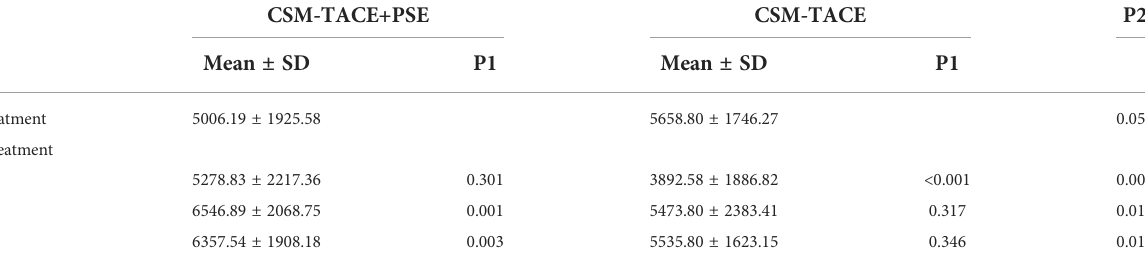
TABLE 9 Follow-up results of cholinesterase (CHE) counts (U/L).